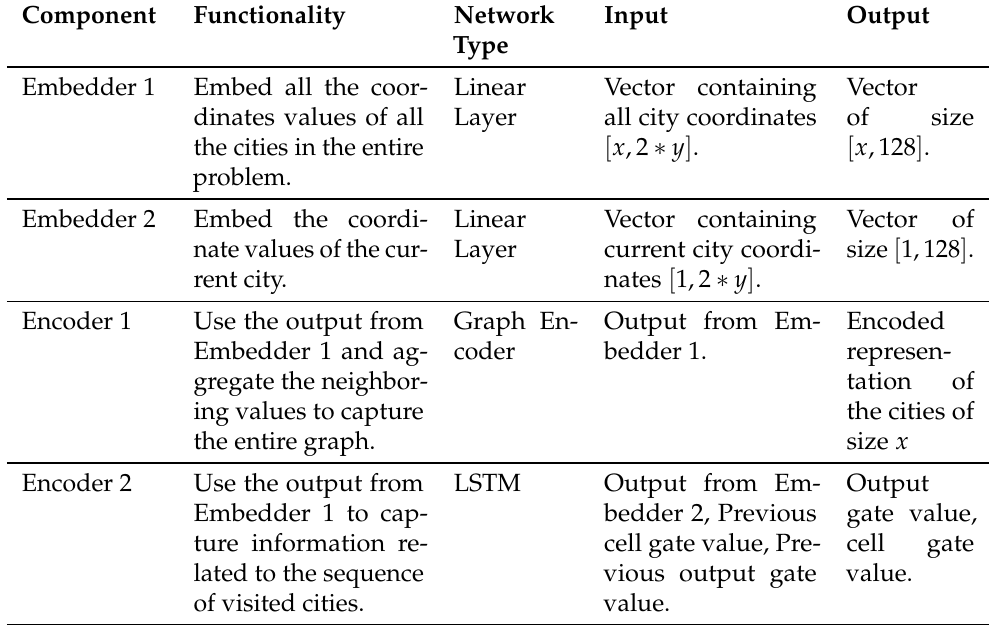
Table 1. The components of the GPN and its functionality. x refers to the number of cities in the TSP and y refers to the number of parameters in the objective. In the bi-objective Euclidean TSP, there are two objectives. Each objective is made up of 2 parameters to represent the coordinates of the